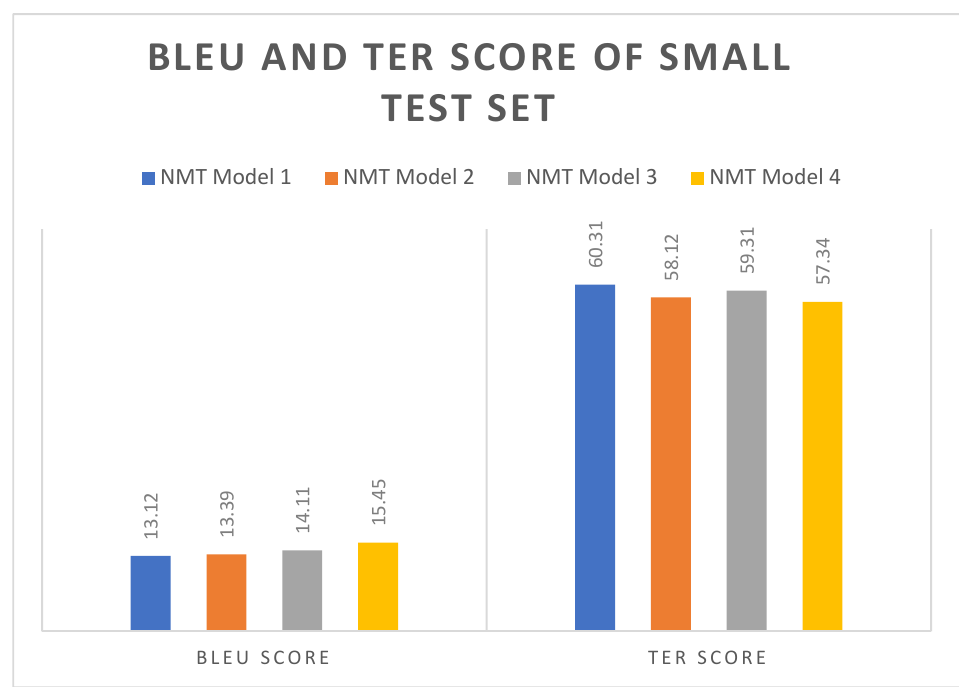
Figure 6. BLEU and TER scores of the small test set.